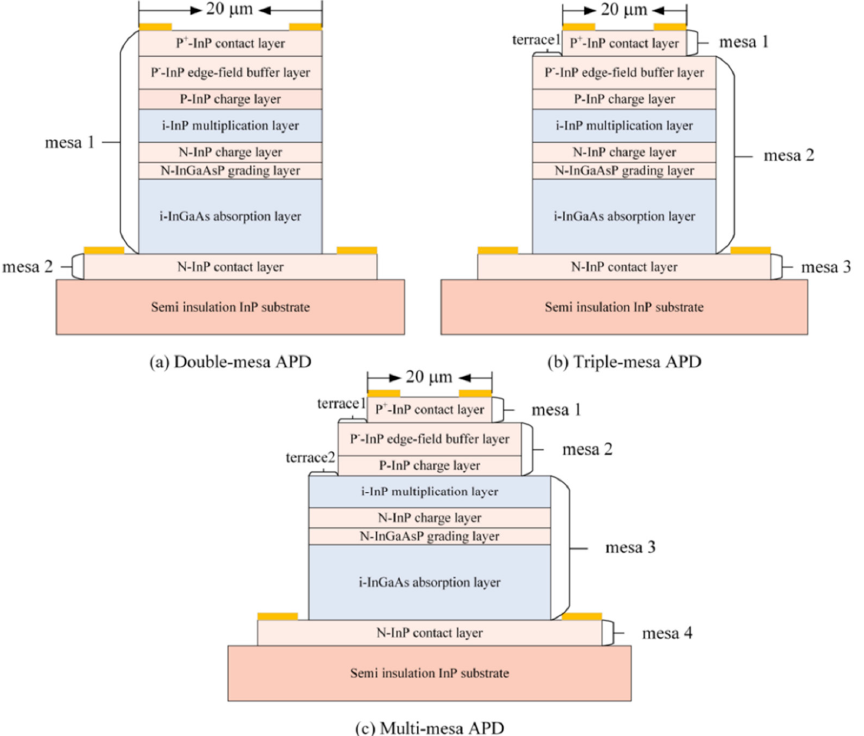
Figure 34. Cross-sectional diagram for the mesa geometry of InGaAs/InAlAs SAGCM APDs with different mesa. Reproduced from [89], AIP Publishing, open access, 2022.